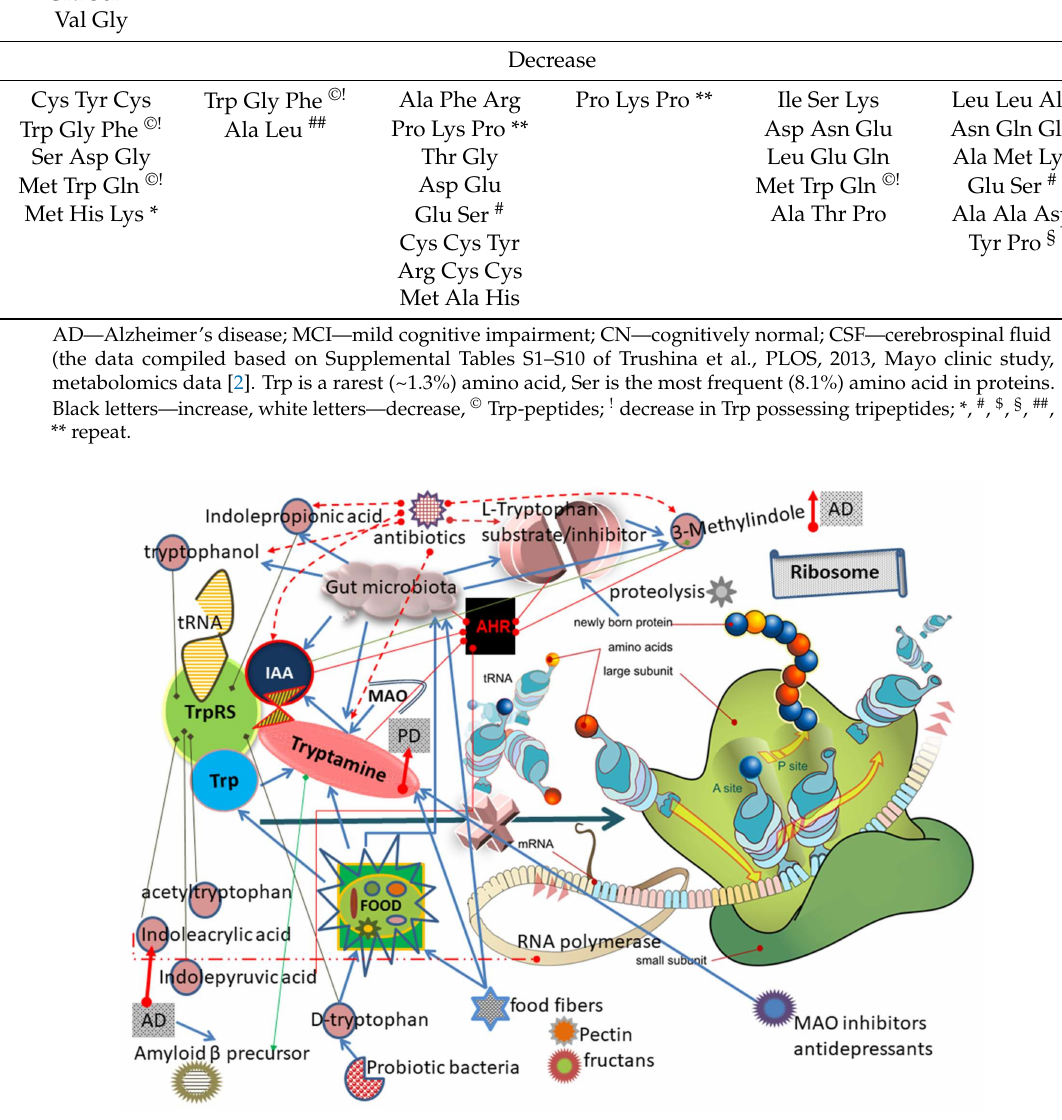
Figure 1. Scheme of inhibition and blockage of protein biosynthesis due to the replacement of Trp from TrpRS with Trp metabolites, the substrate-like inhibitors of TrpRS (abbreviations and explanations are in the